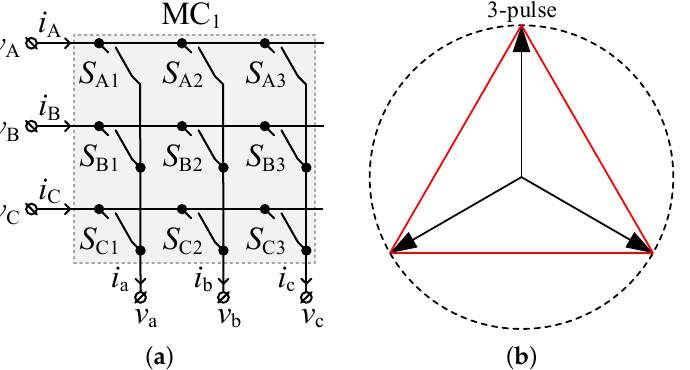
Figure 4. Conventional matrix converter as a 3-pulse system: ( a ) schematic diagram, ( b ) the voltages discrete